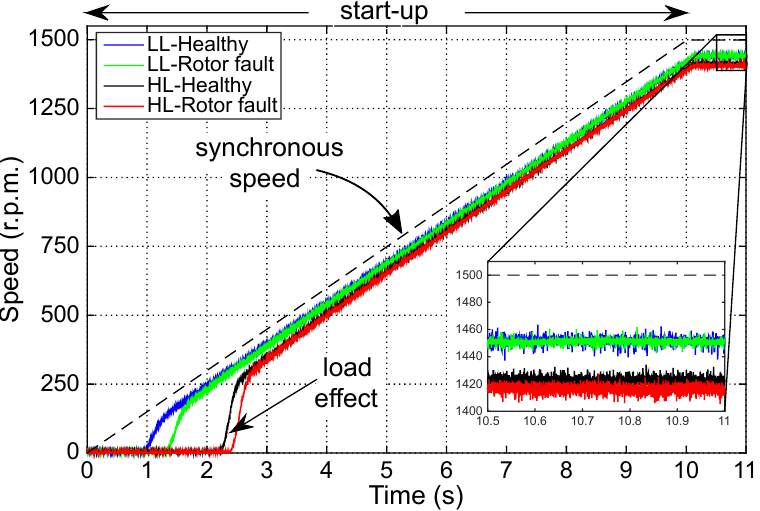
Figure 7. Startup transients performance of the speed in an induction motor fed by an inverter for healthy and faulty cases under low (LL) and high (HL) levels of mechanical